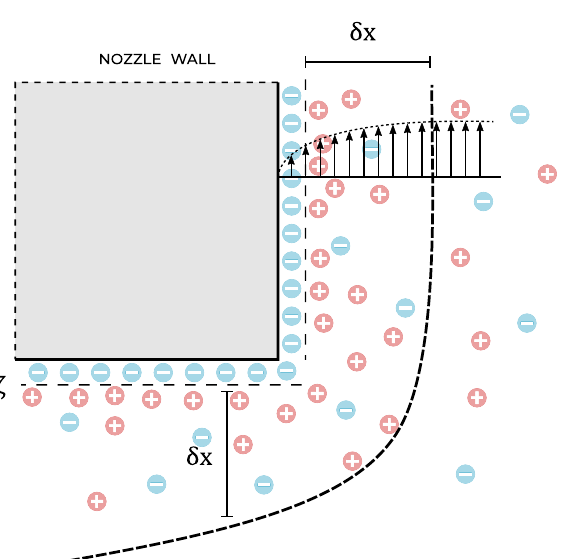
Figure 6. Hydrodynamic boundary layer velocity profile interacting with the electrical double layer. When a material comes into contact with a liquid it will release or absorb some ions according to its zeta potential. For charge neutrality counterions will move towards the surface to form a diffusive double layer. For laminar flow through short channels, liquid flow goes from zero near the wall up to the bulk velocity v over some boundary layer thickness δ x . The charging depends on this layer thickness, which scales as δ x